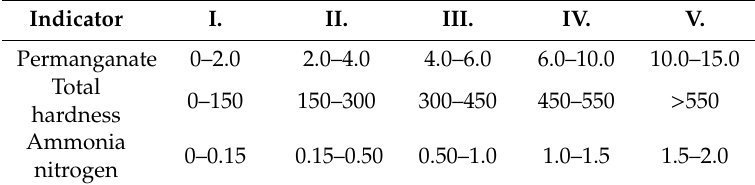
Table 2. Water quality level and content of permanganate, total hardness, and ammonia nitrogen.